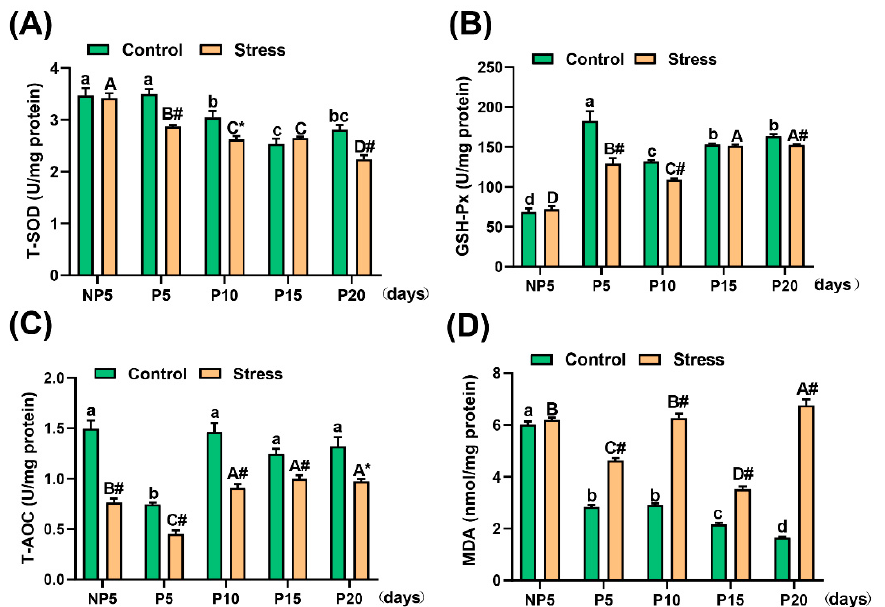
Figure 4. Effects of restraint stress on the oxidative stress states in the uterus in pregnant mice. These graphs show the contents of total superoxide dismutase (T-SOD) ( A ), glutathione peroxidase (GSH-Px) ( B ), total antioxidant capacity (T-AOC) ( C ), and malondialdehyde (MDA) ( D ) in the uterus of the control and stress group at NP5, P5, P10, P15, and P20. Restraint stress reduced the levels of T-SOD ( A ), GSH-Px ( B ), and total antioxidant capacity ( C ) in pregnant mice, resulting in increased lipid peroxide MDA content ( D ). In conclusion, restraint stress reduced the antioxidant capacity of the uterus in pregnant mice. Values are expressed as the mean ± SEM. Lowercase letters in the column (a, b, c, d) represent the differences between NP5 ( n = 10), P5 ( n = 10), P10 ( n = 10), P15 ( n = 10), and P20 ( n = 10) in the control group ( p < 0.05), and uppercase letters in the column (A, B, C and D) represent the differences between NP5 ( n = 10), P5 ( n = 10), P10 ( n = 10), P15 ( n = 10), and P20 ( n = 10) in the stress group ( p < 0.05). * p < 0.05 and # p < 0.01 were used to denote the significance of the stress group compared with the corresponding control group.